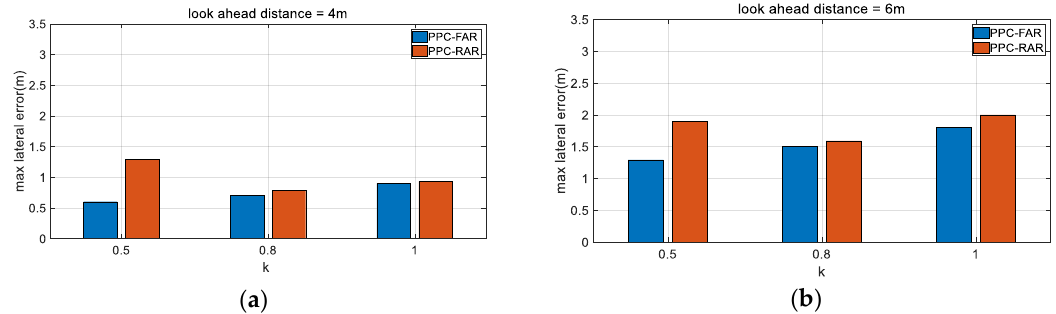
Figure 16. Maximum lateral error. ( a ) Look-ahead distance is 4 m. ( b ) Look-ahead distance is 6 m.